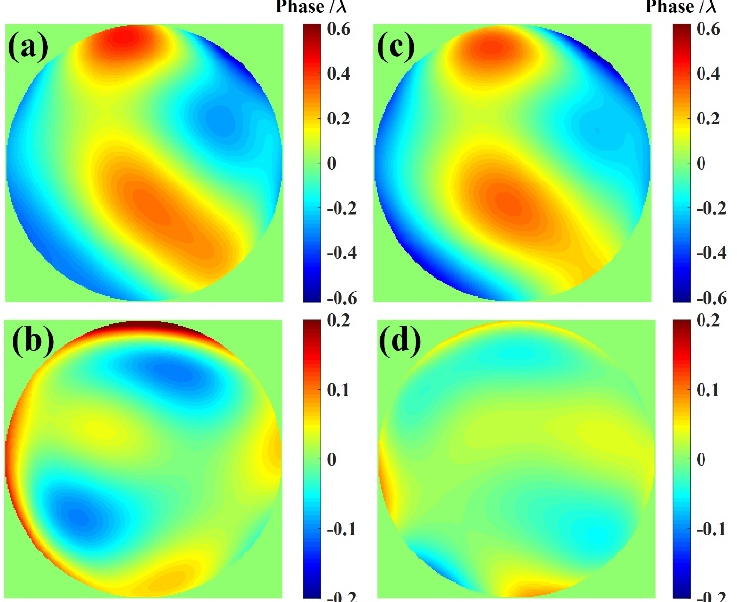
Figure 14. Reconstructed wavefront and residual wavefront. ( a , b ) Reconstructed wavefront and residual wavefront based on SHWFS. ( c , d ) Reconstructed wavefront and residual wavefront based on FBPM-SHWFS.